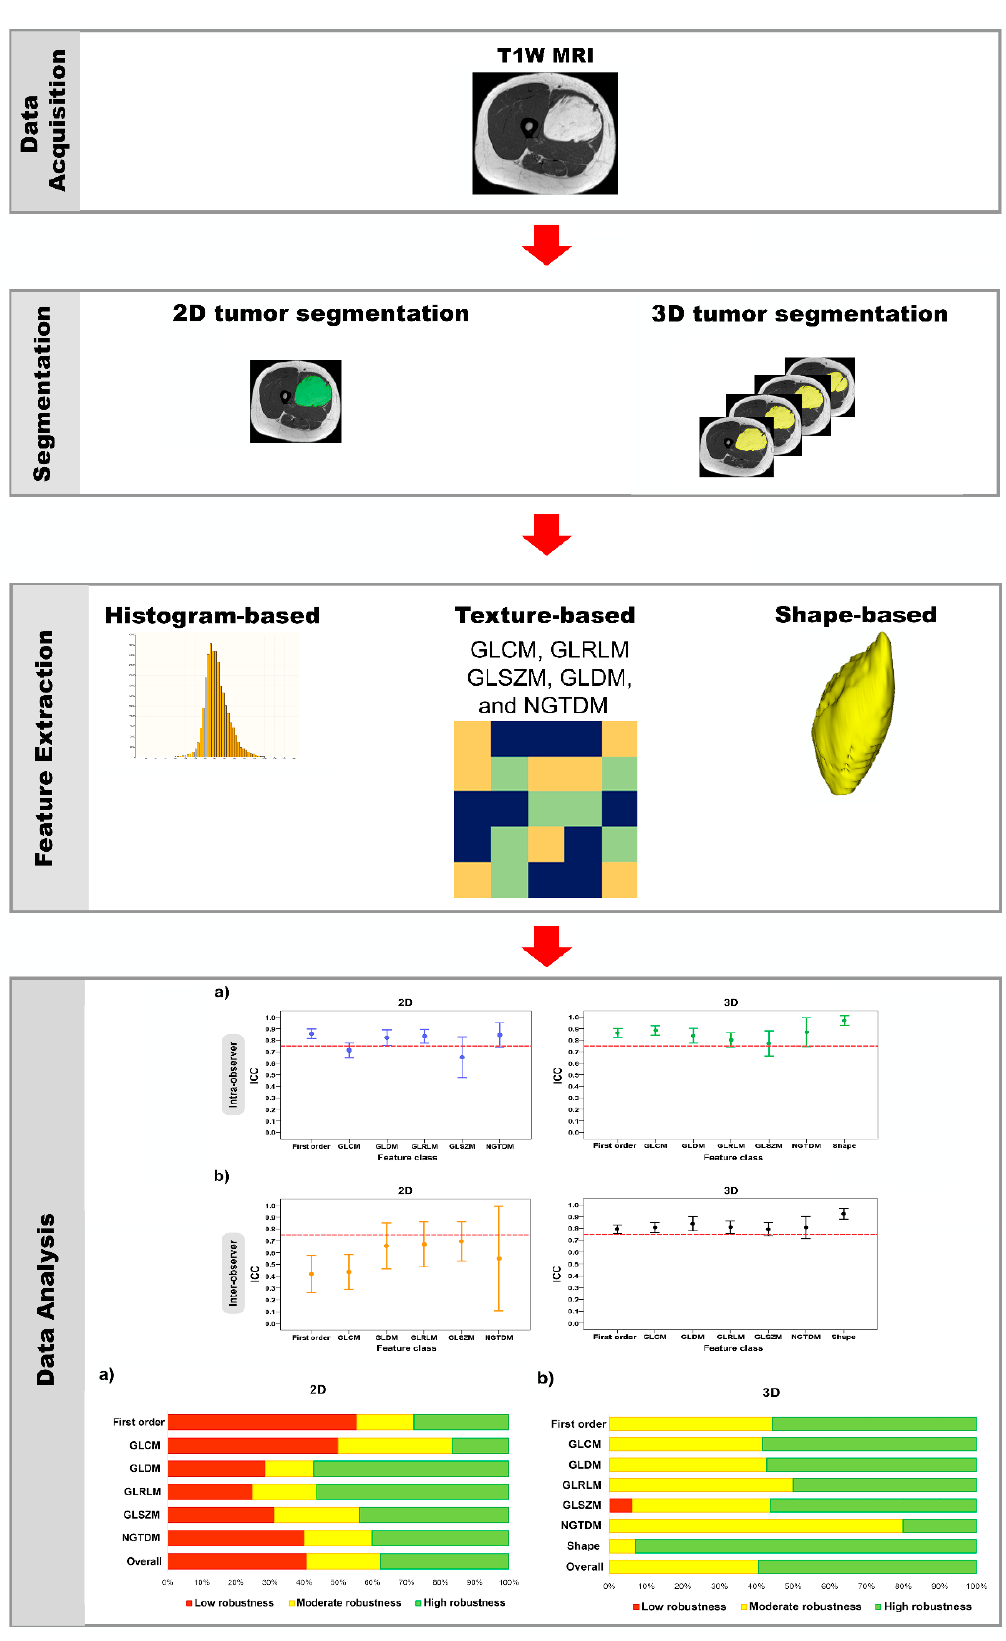
Figure 2. Schematic diagram of the method used in this study. All segmentations were performed by using a competitive region growing algorithm implemented in 3D Slicer, with a manual correction. Regarding N-class segmentation, the